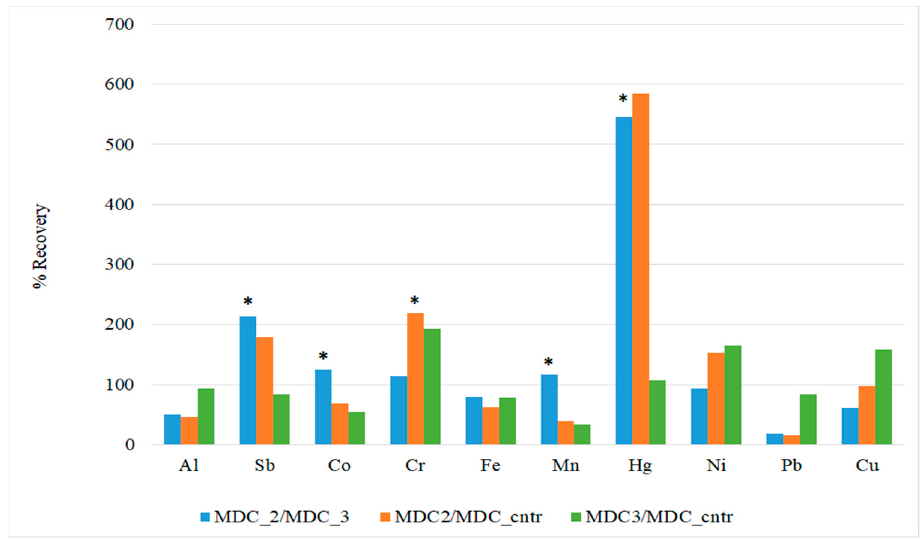
Figure 4. Percentage of metal recovery from MDC_2 membranes in comparison to MDC_3 (MDC_2/MDC_3) and MDC_CNTR (MDC_2/MDC_CNTR). MDC_3/MDC_CNTR: percentage of the metal recovery in MDC_3 in compari-